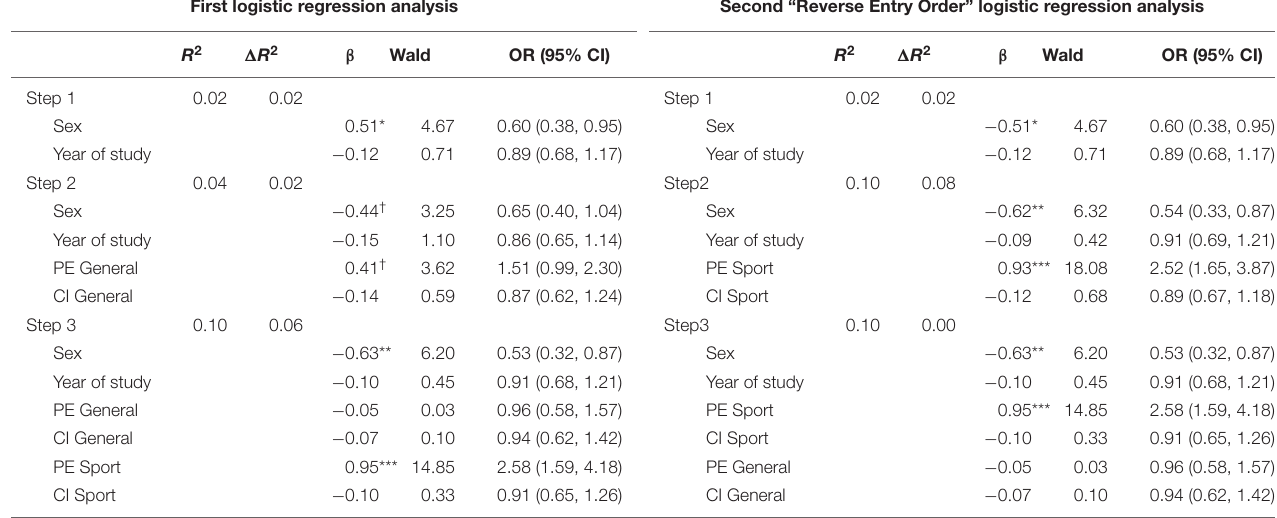
TABLE 5 | Two logistic regression analyses predicting the likelihood of competitive sport level. First logistic regression analysis Second “Reverse Entry Order” logistic regression